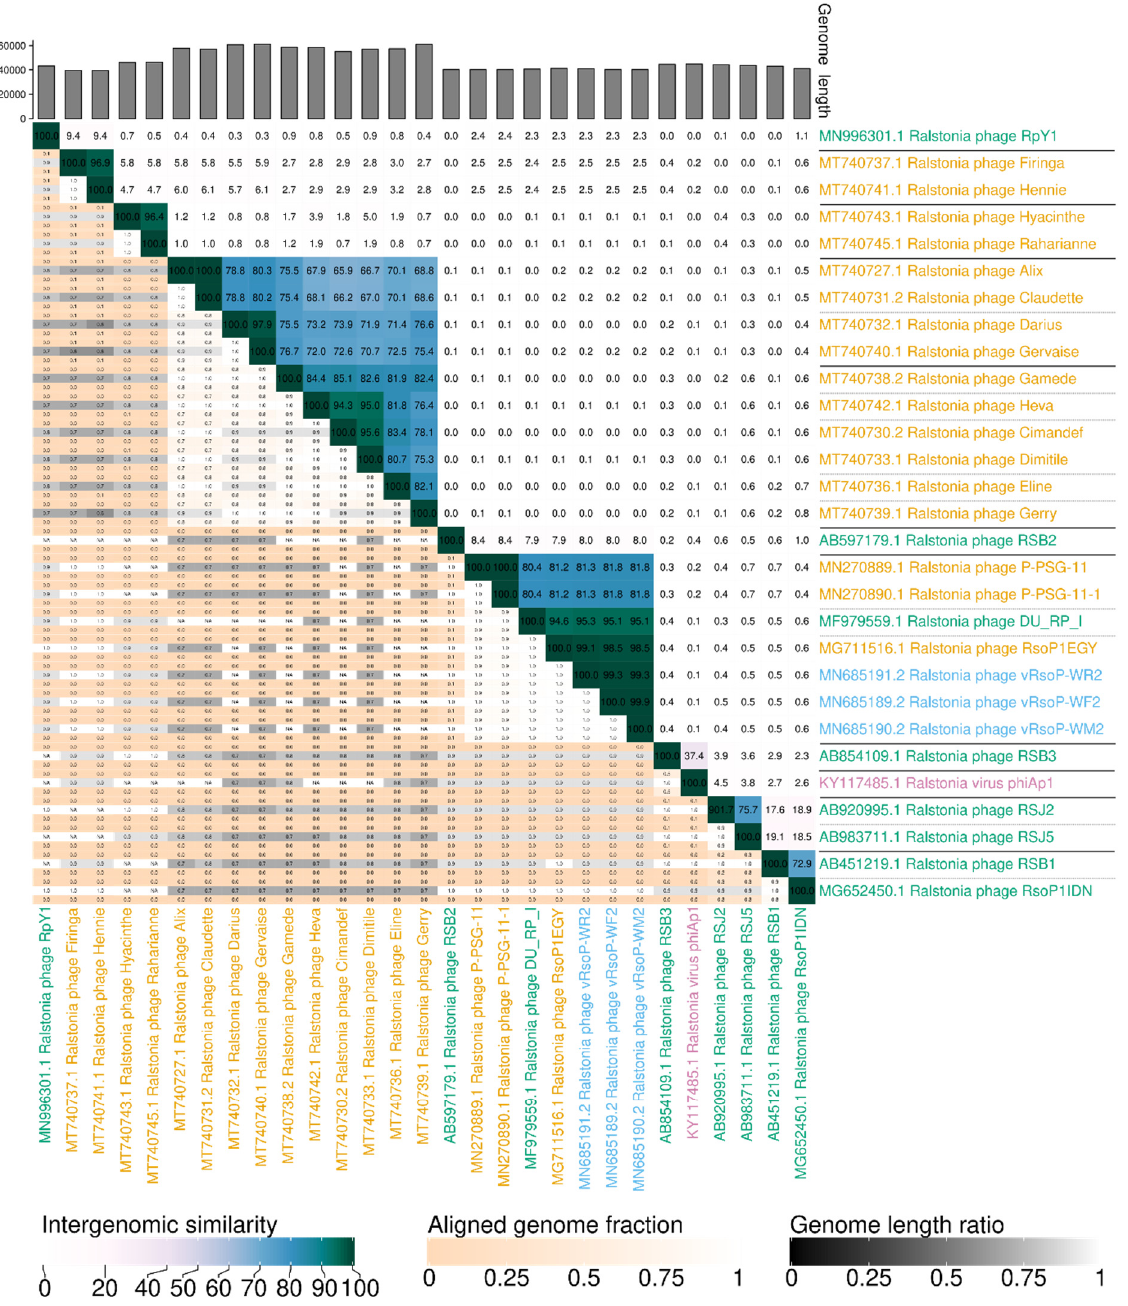
Figure 5. VIRIDIC generated heatmap of European water phages vRsoP-WF2, vRsoP-WM2 and vRsoP-WR2 genomes and a selection of 26 genomes of closely related R. solanacearum and R. pseudosolanacearum phages from other sources and continents. The heatmap incorporates intergenomic similarity values (top-right half) and alignment indicators (bottom-left half): aligned fraction of genome in row, genome length ratio and aligned fraction of genome in column. The black lines separate the predicted genera and the gray dashed lines separate the species. The geographical origin of the phages is indicated by the following colours: Africa (orange), Asia (green), Europe (blue) and America (purple).